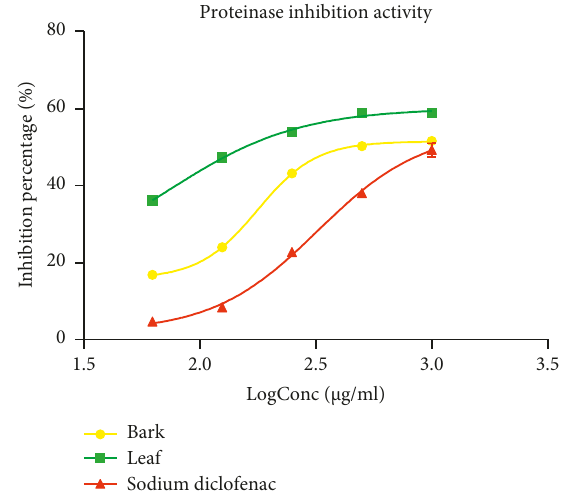
Figure 6: Lipase inhibitory activity of the hydro-ethanolic leaf and bark extract of Psychotria densinervia and orlistat. Values are expressed as mean ± SD ( n �